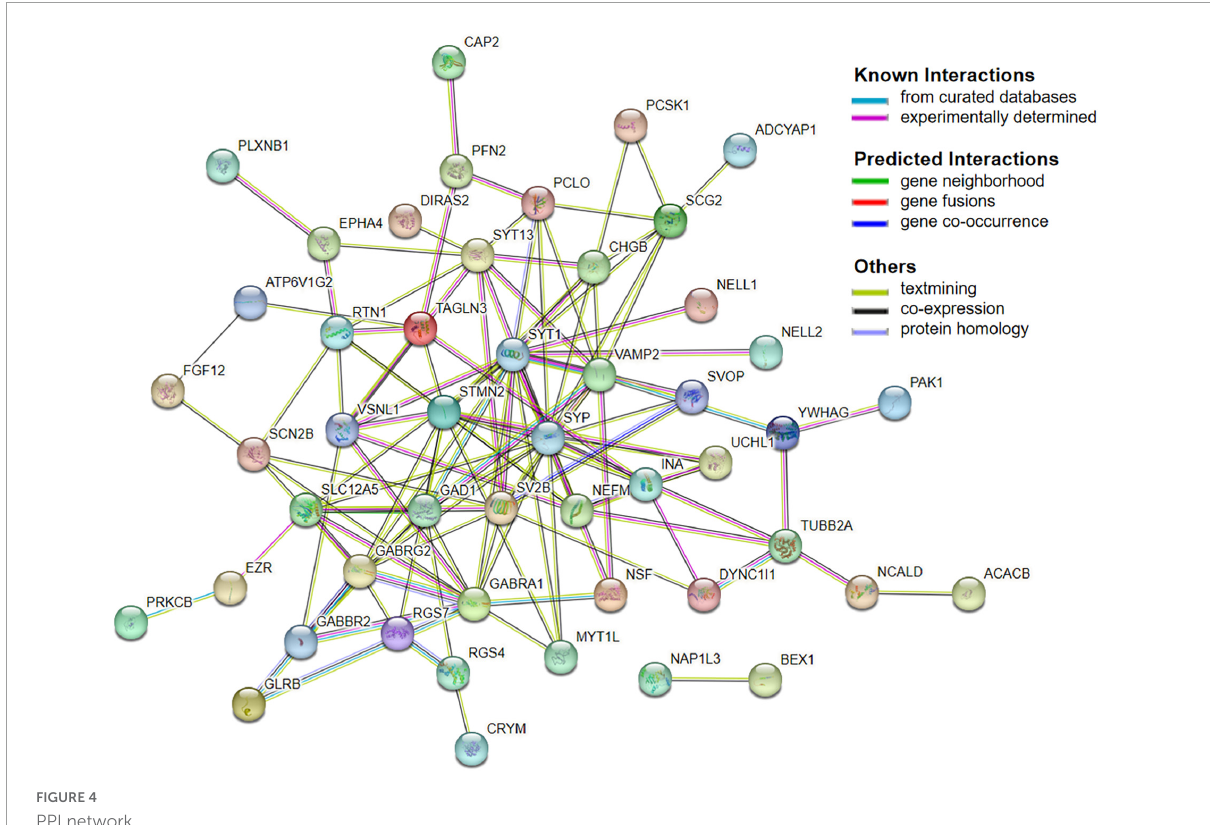
FIGURE4 PPI network.